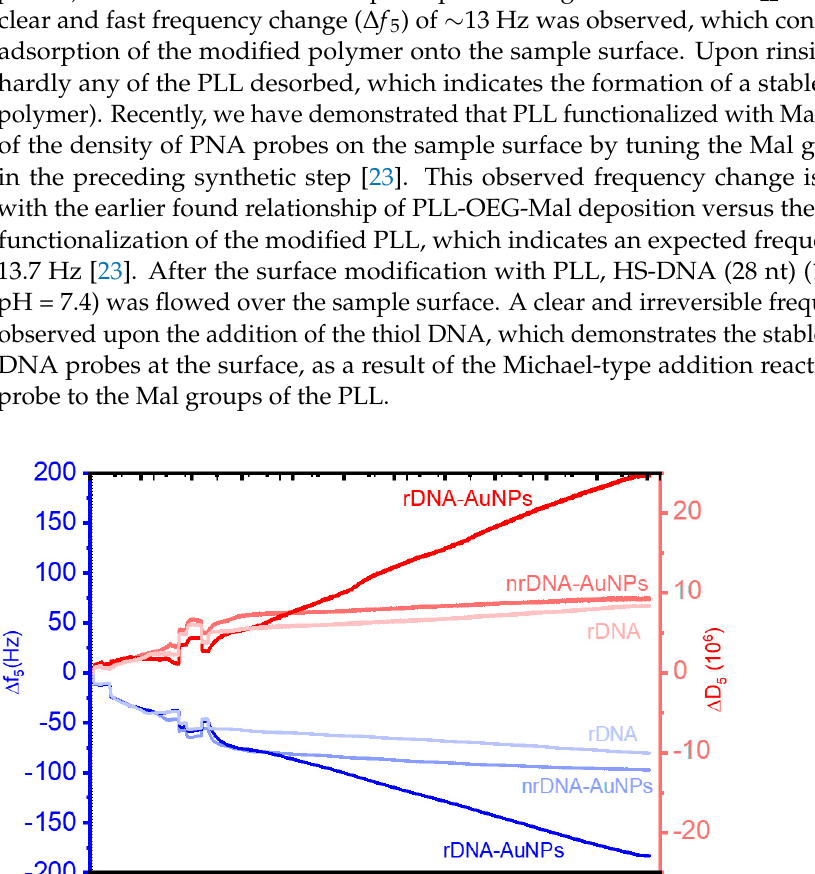
Figure 2. Cyclic voltammograms of gold substrates before and after coating with: monolayer of PLL- OEG 22 -Mal 4.6 and HS-DNA, tDNA, and then followed by rDNA, rDNA-AuNPs or nrDNA-AuNPs. ( a ) Stages of preparation the sensing layer, adsorption of PLL, immobilization of the HS-DNA probe